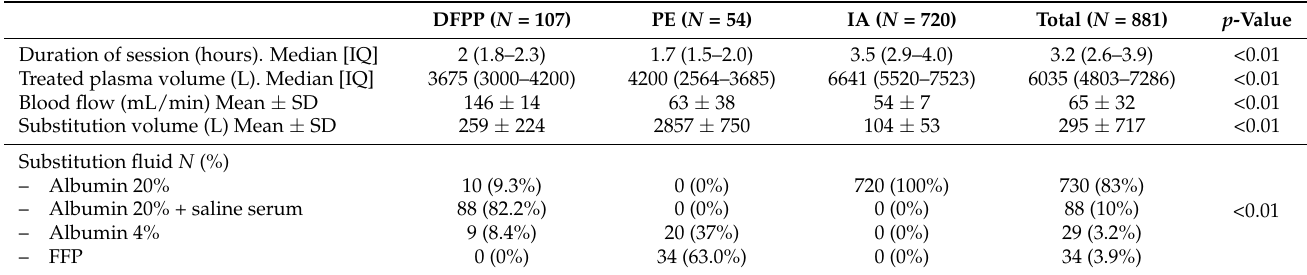
Table 2. Characteristics of sessions according to apheresis technique.